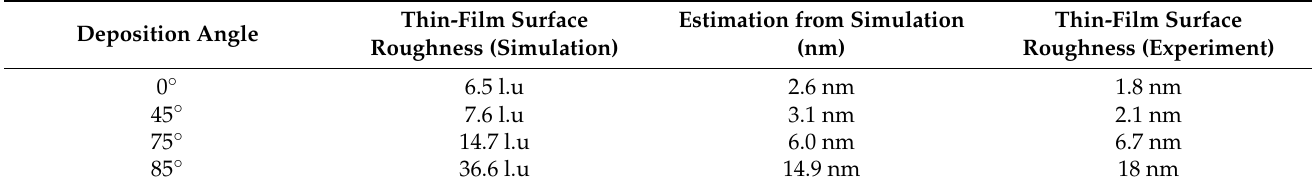
Table 4. Comparison of surface roughness of simulation results and the experimental results.